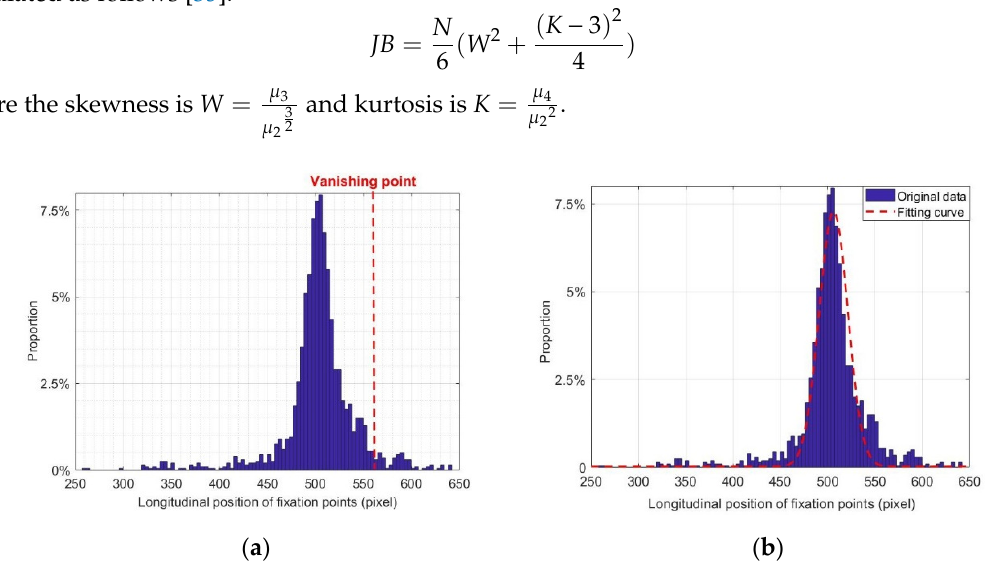
Figure 9. Fixation point distribution of subject 1 on a straight lane at 50 km/h: ( a ) vanishing point test and ( b ) fitting of distribution curve.